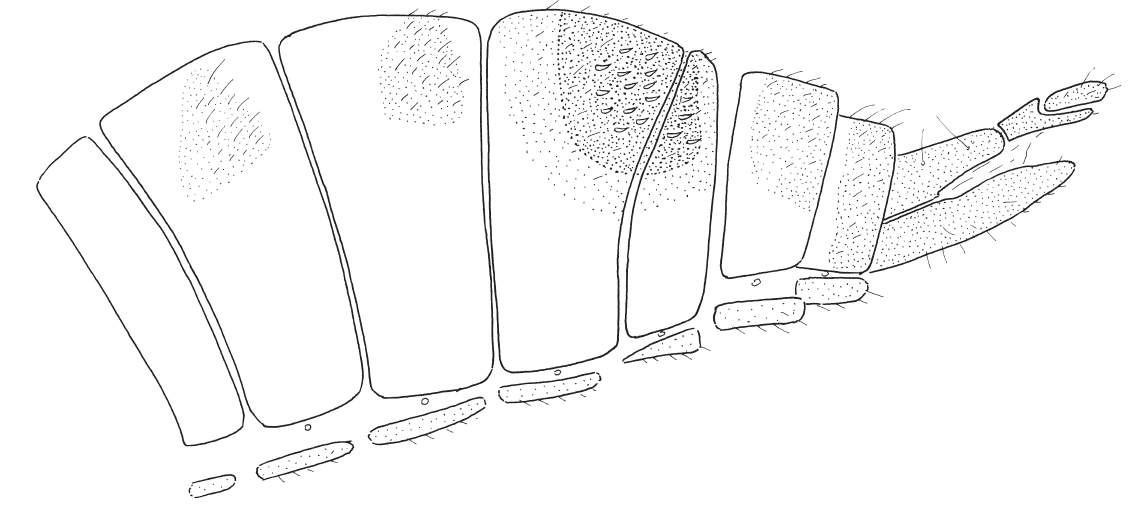
Fig. 127 . Elaphropeza limosa Shamshev & Grootaert, 2007, ♀ abdomen, lateral view.